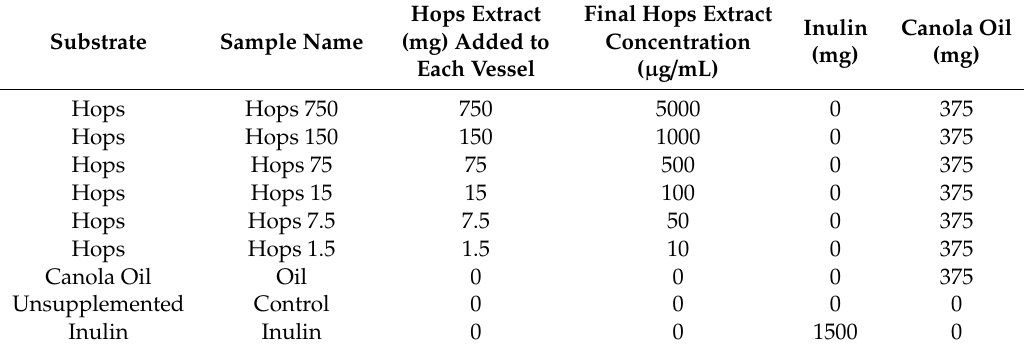
Table 1. Substrate concentrations in each of the nine fermentations conducted in